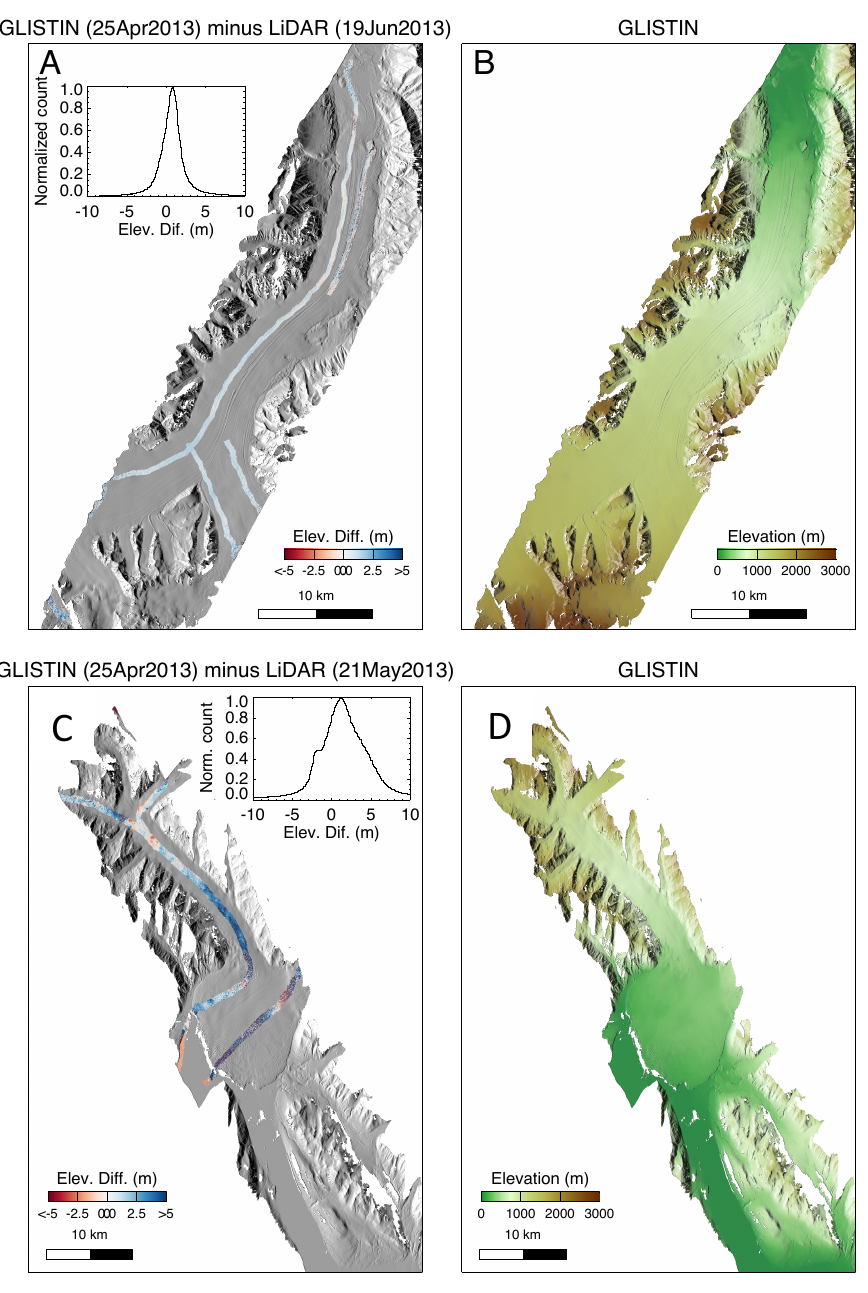
Figure 3. ( A ) GLISTIN-A shaded relief height map of Nabesna glacier overlaid with lidar track and GLISTIN-A—lidar elevation differences (see also inset). ( B ) GLISTIN-A digital elevation map of Nabesna generated from a mosaic of two overlapping GLISTIN-A swaths. ( C ) GLISTIN shaded relief height map of Hubbard glacier overlaid with lidar track and GLISTIN-A—lidar elevation differences (see also inset). ( D ) GLISTIN-A digital elevation map of Hubbard generated from a mosaic of two overlapping GLISTIN-A